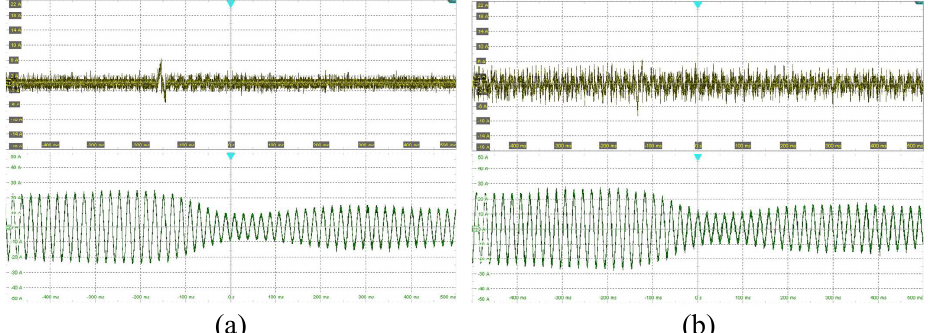
Figure 24. The tracking error and the grid current when the controller is used at 51 Hz. ( a ) VVS. ( b )